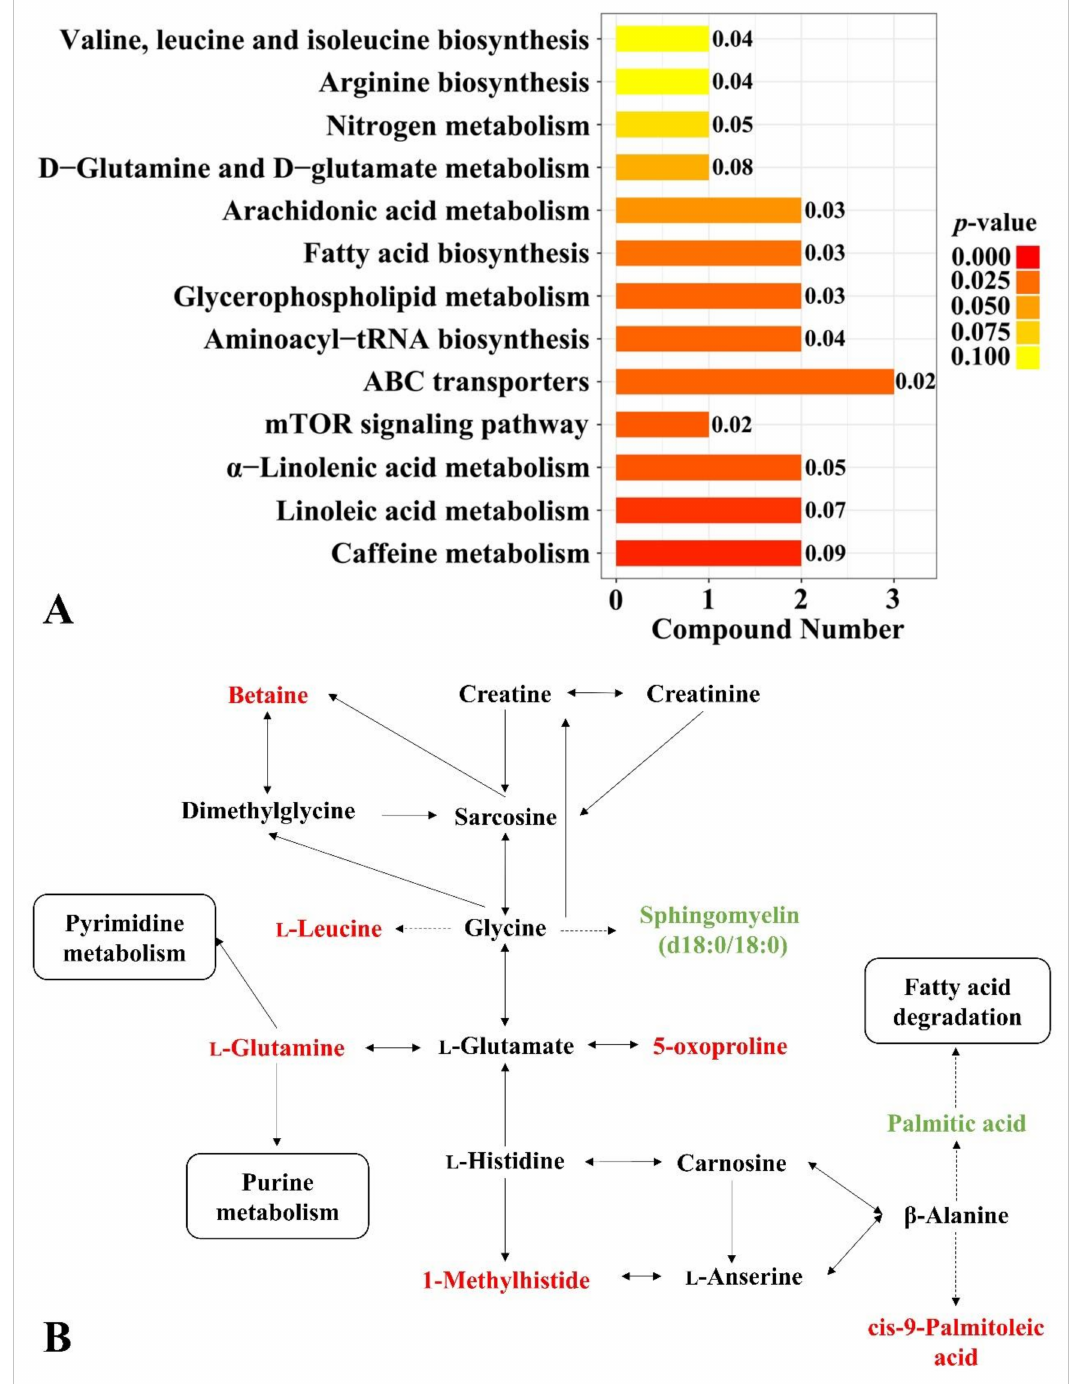
Figure 2. Changes in metabolic pathways and serum metabolites with MG supplementation. ( A ) differen- tial serum metabolic pathways (compound number were the total count of metabolites related to metabolic pathways); ( B ) metabolites in red and green were up-regulated and down-regulated, respectively.